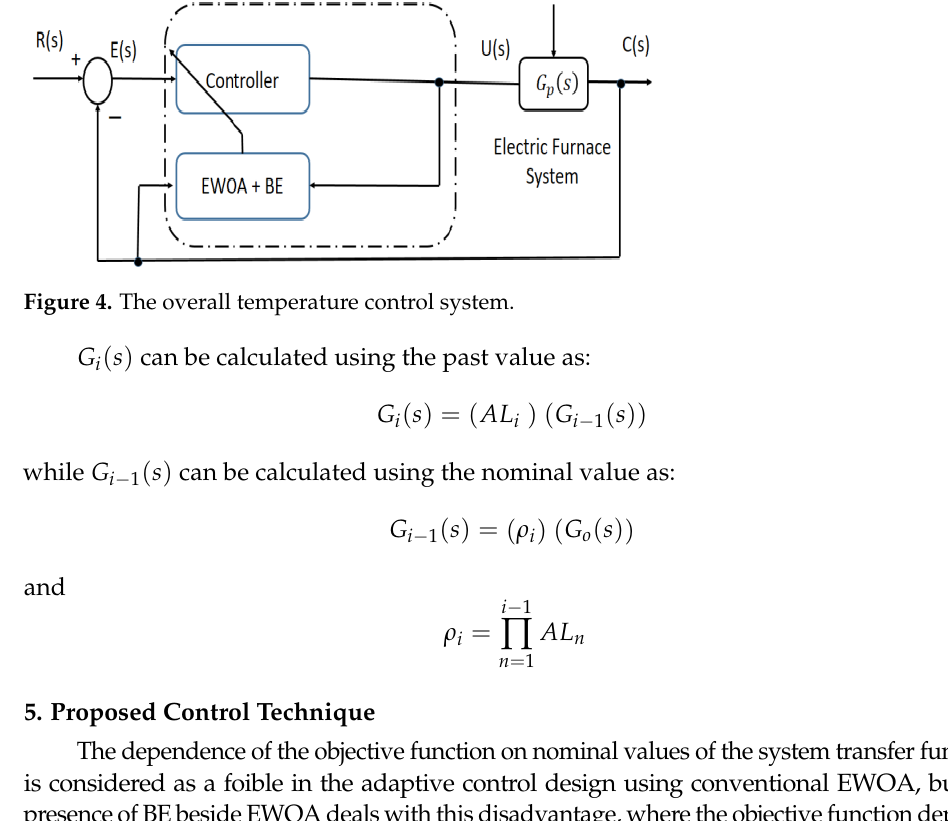
Figure 3. Balloon effect concept for any optimizers at iteration (i).